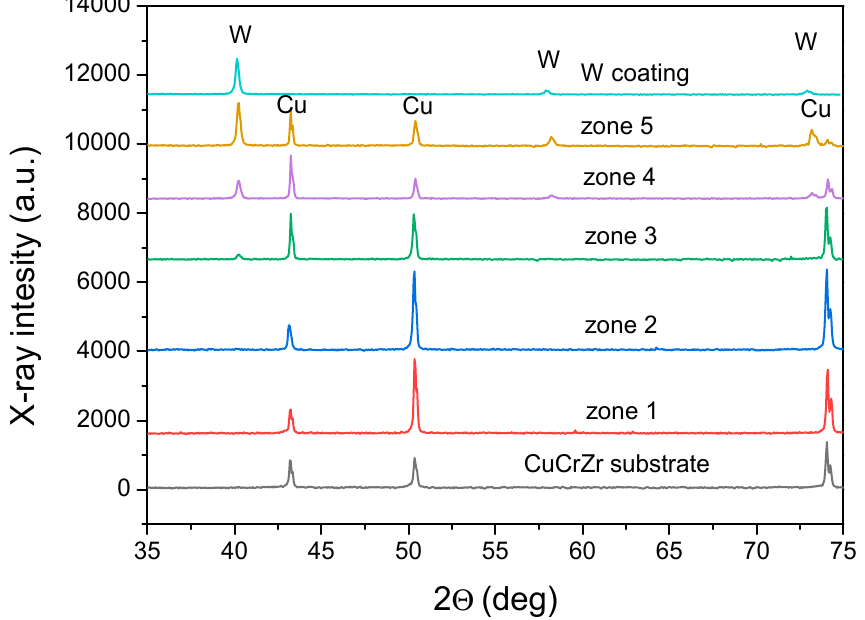
Figure 6. XRD patterns collected in the CuCrZr substrate, W coating, and five different zones along the interlayer.